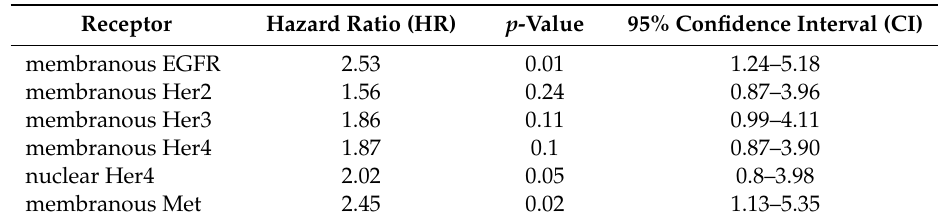
Table 4. Prognostic factors on five-year overall survival from the multivariate cox regression analysis (adjustment for p16 and UICC Stages).